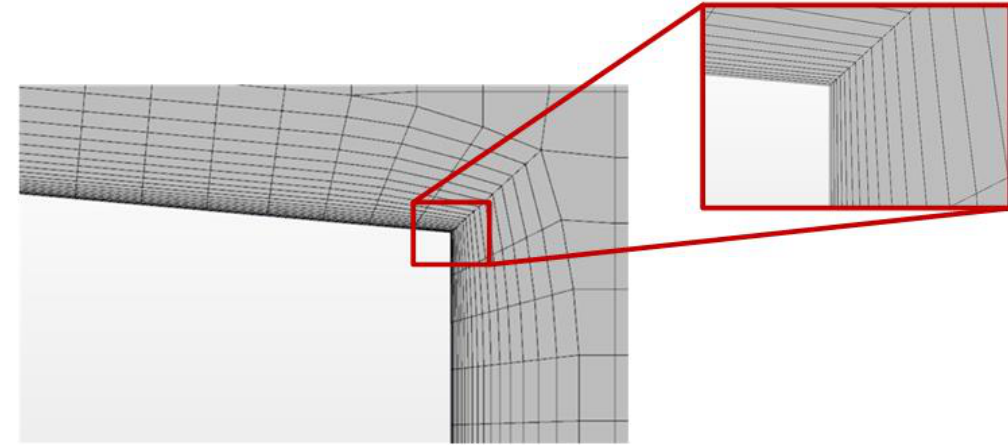
Figure 4. Boundary layer mesh of the hydrofoil’s trailing edge.